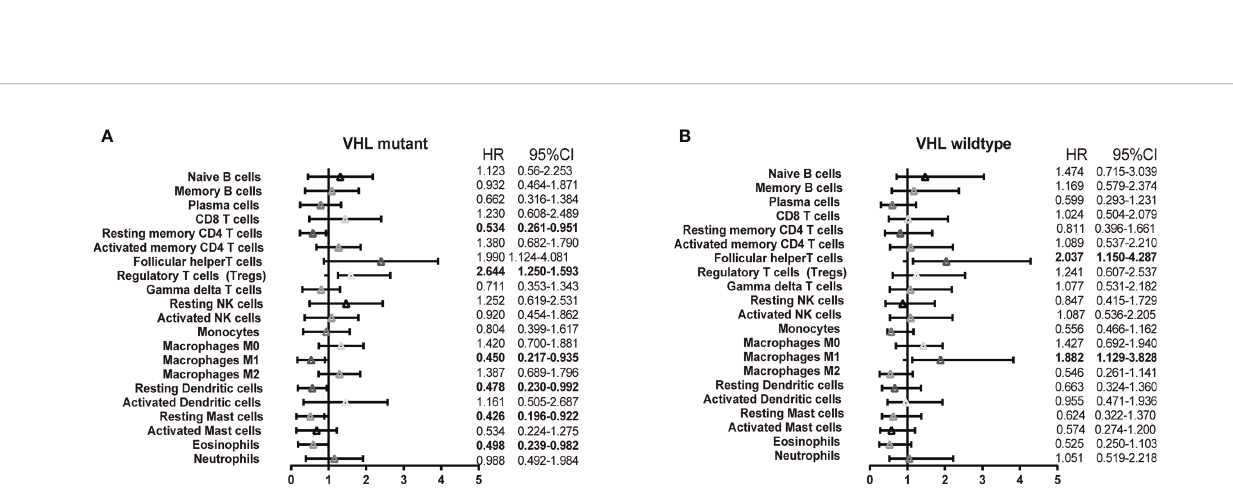
Frontiers in Oncology |